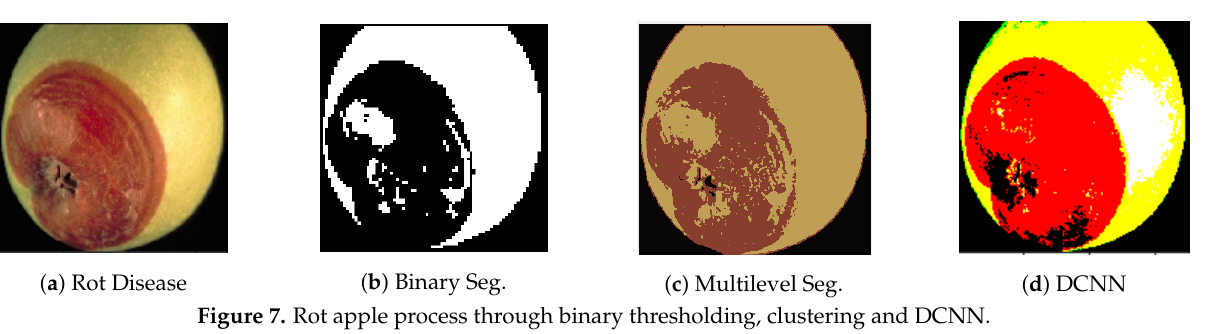
Figure 6. Scab apple process through binary thresholding, clustering and DCNN.